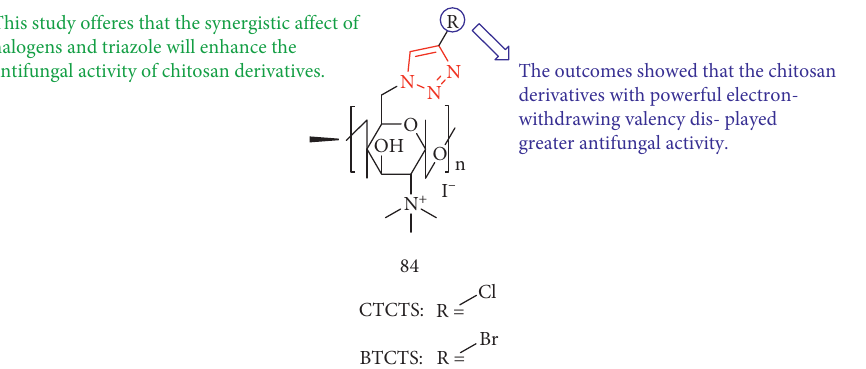
Figure 34: Chemical structure of water-soluble chitosan derivatives with